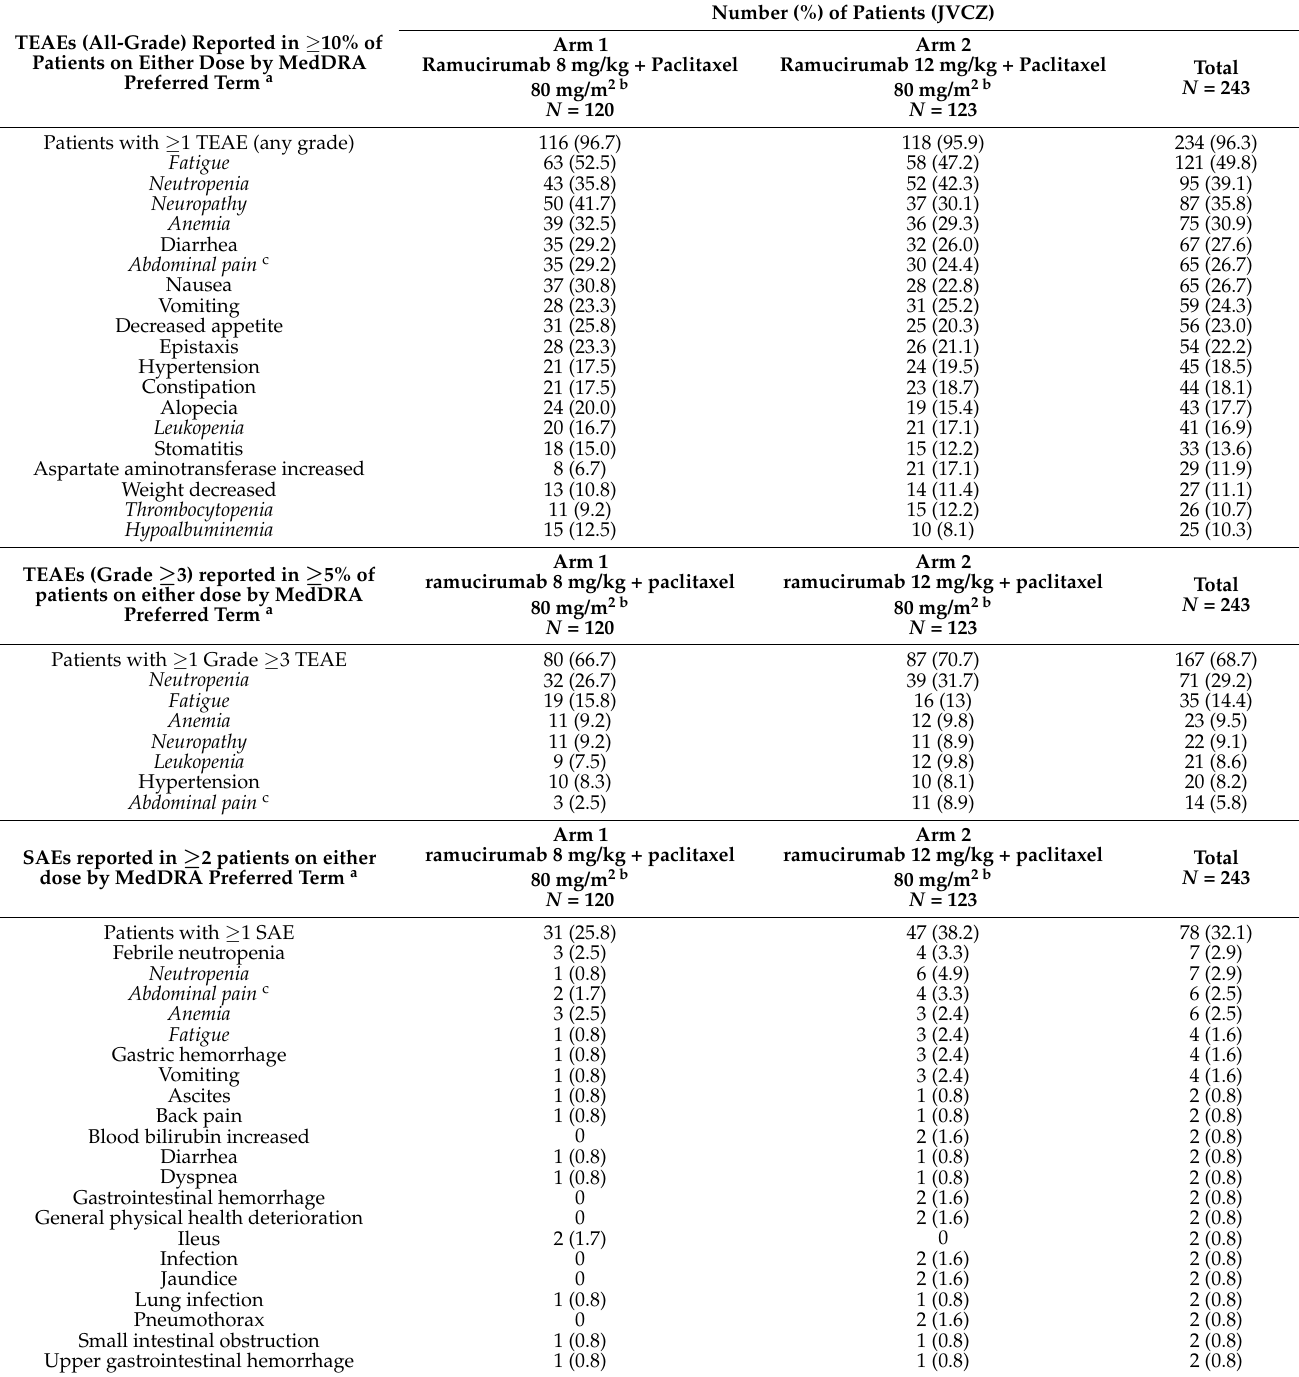
Table 2. Study JVCZ: treatment-emergent adverse events and serious adverse